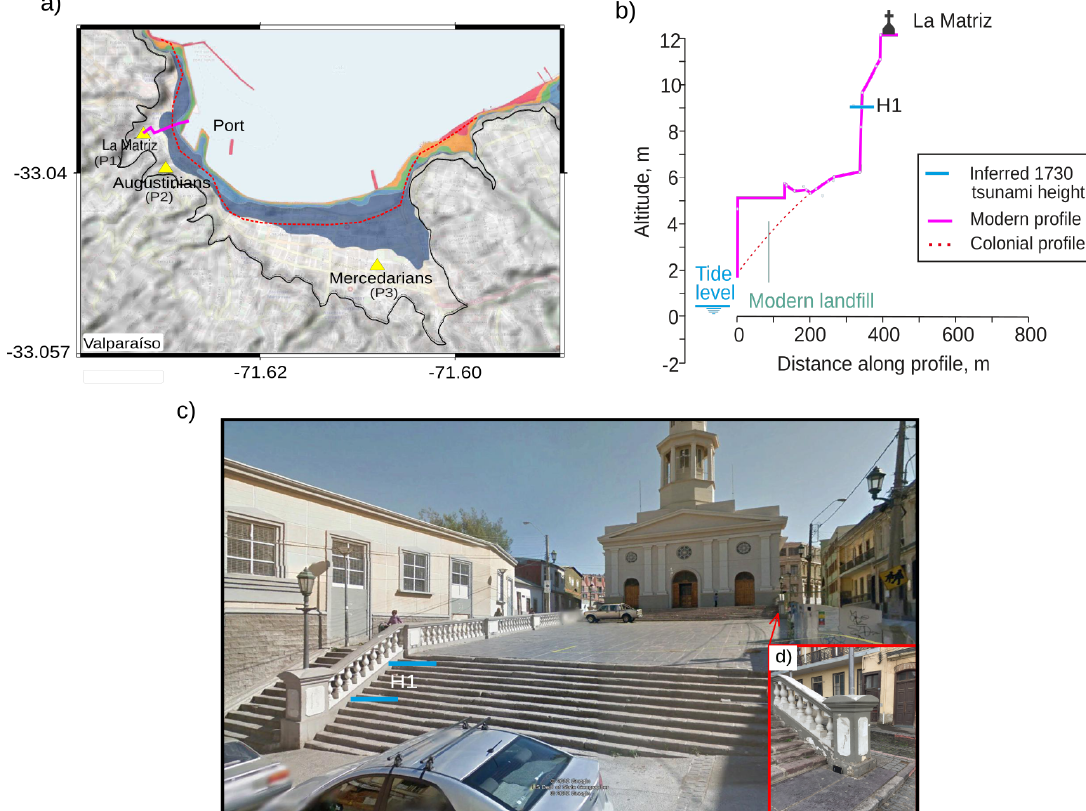
Figure 2. ( a ) Map showing the extent of maximum tsunami inundation and flow depths according to the Tsunami Inundation Chart for Valparaíso and Viña del Mar (CITSU, in Spanish) according to [3], as well as the location of the maximum tsunami height reported in historical records (yellow triangles) shown also in Figure 1; the profile line is shown in magenta, and the colonial coastal line [1] is shown in red. ( b ) The topographic profile along La Matriz (P1), where tsunami records suggested a 9 m tsunami height (light blue line), modified from [1]. ( c ) Photo of La Matriz Church (provided by Google Maps [9]), where light blue lines indicate the estimated position range of the maximum tsunami height recorded for the 1730 event and the red arrow shows where a plate was supposed to be located (refer also to the first section of Supplementary Material